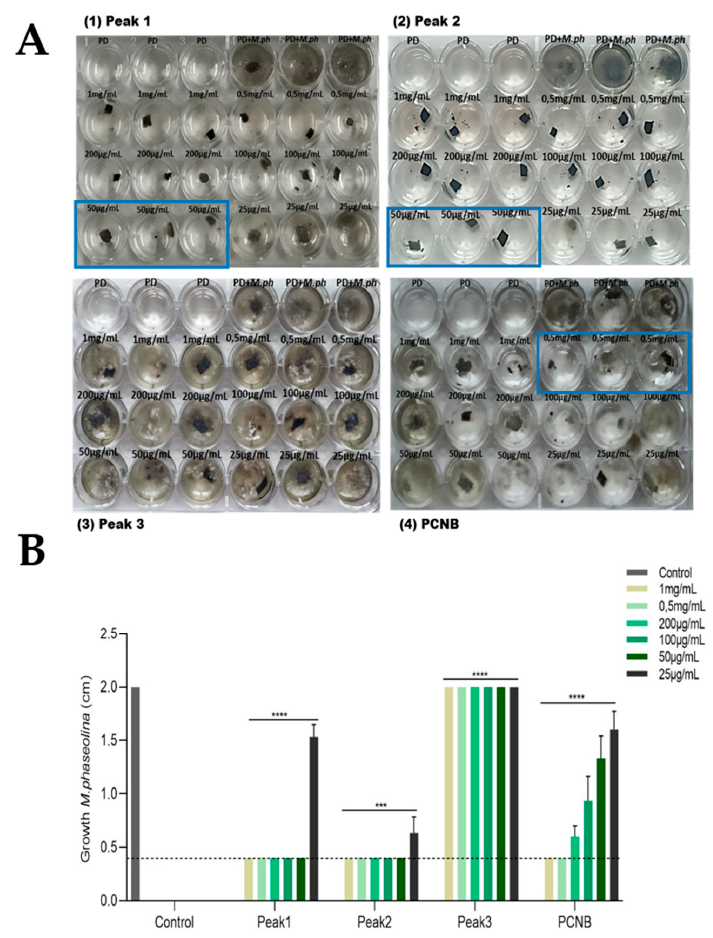
Figure 6. Minimum inhibitory concentrations of purified fractions of 72-CFS on fungal growth. ( A ) Minimum inhibitory concentration of the antifungal compound present in pick 1 (Panel 1), pick 2 (Panel 2) and pick 3 (Panel 3) of purified fractions of 72-CFS using a 24-well plate assay. The concentrations are indicated. Fungal plugs incubated with only PD broth (PD + M. phaseolina ) and ( B ) Graphical representation of the MIC assay. The dotted line indicates the starting size (mm) of M. phaseolina plug (4 × 4 mm) at the beginning of the experiment. The results were obtained after 5 days of incubation at 28 ◦ C. Data are presented as means ± standard deviation ( n = 3 replication for each different concentration). ANOVA statistical analysis is extremely significant indicated—**** p < 0.0001 and *** p <